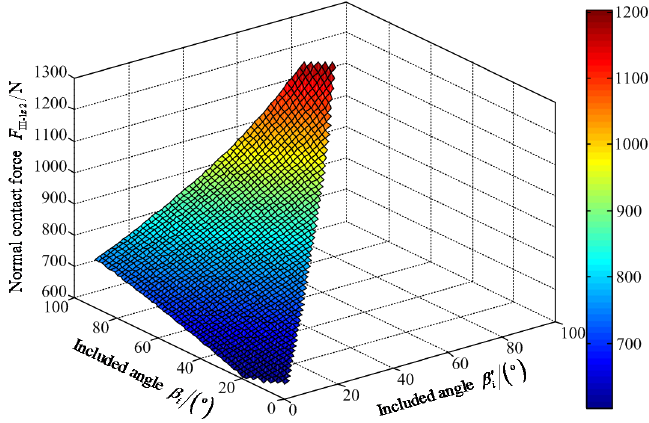
Figure 16. Variable tendency chart of normal contact force F III ‐ 1 z 2 with the changes of β i ′ and β i .